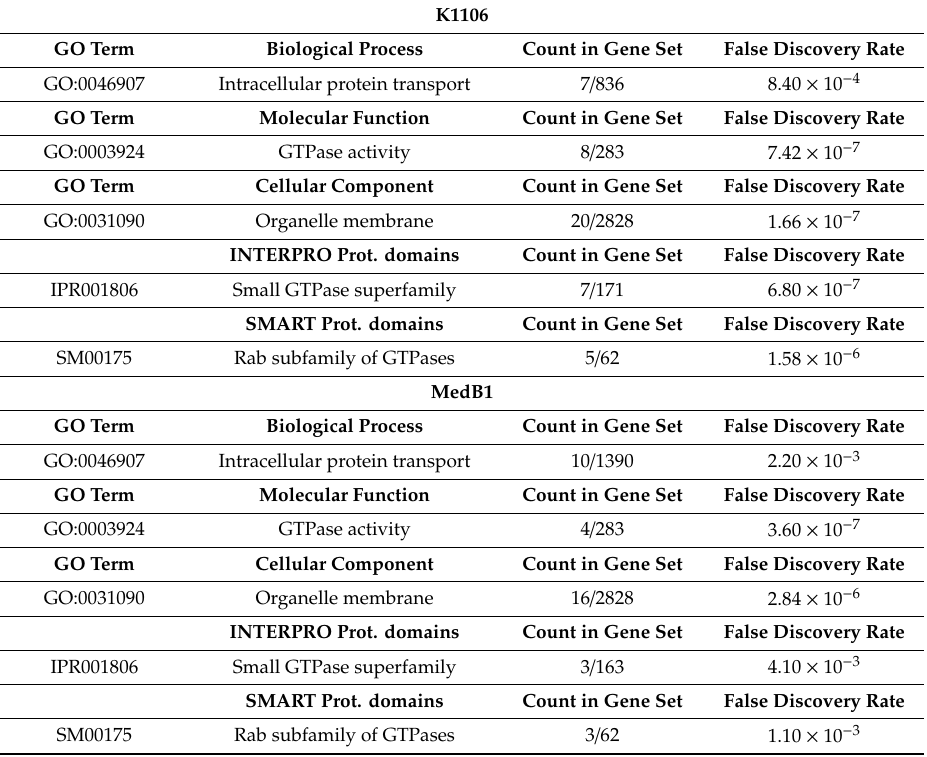
Table 1. Enrichment for XPO1 interactors identified in K1106 and MedB1 cells with STRING